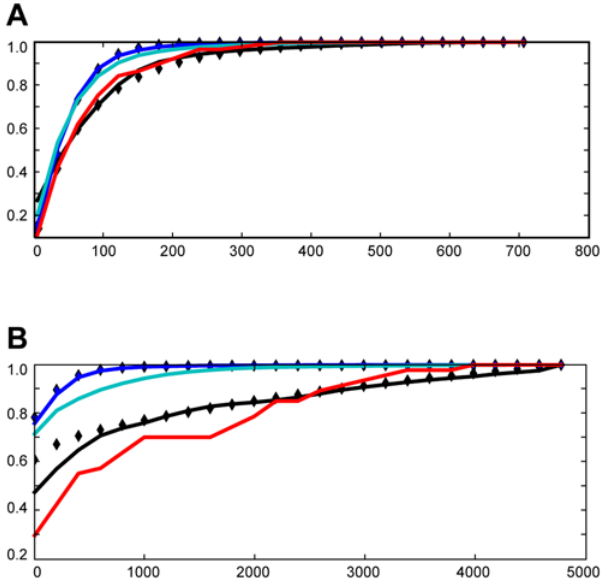
Figure 5. Size and spacing of highly conserved regions of human, Drosophila and tephritid genomes demonstrate global differences in constraint landscapes. Cumulative sums of normal- ized histograms are displayed for the sizes of conserved blocks (panel A) and the distances between them, i.e. the sizes of non-conserved intervals (panel B). Distributions of conserved region sizes are similar for Drosophila , C. capitata and human. Spacing between conserved regions, however, shows very different distributions in Drosophila and human; C. capitata conserved element spacings are similar to those observed in the human genome. Distributions are shown for UCSC phastCons ‘‘most conserved’’ tracks for human (black diamonds) and D. melanogaster (blue diamonds) as well as for phastCons run in-house on tephritid alignments (red line). In addition, D. virilis conserved block sizes and spacing (cyan line in panels A and B) are shown in order to assess the utility of a species with a large genome in supplying inter-element spacing information akin to vertebrates and tephritids (see text). In- house alignments and phastCons data are similarly displayed for D. melanogaster referenced Drosophila alignments (blue line) and for human referenced vertebrate alignments in 1% of the human genome (black line) in order to establish consistency between our analyses and UCSC datasets.